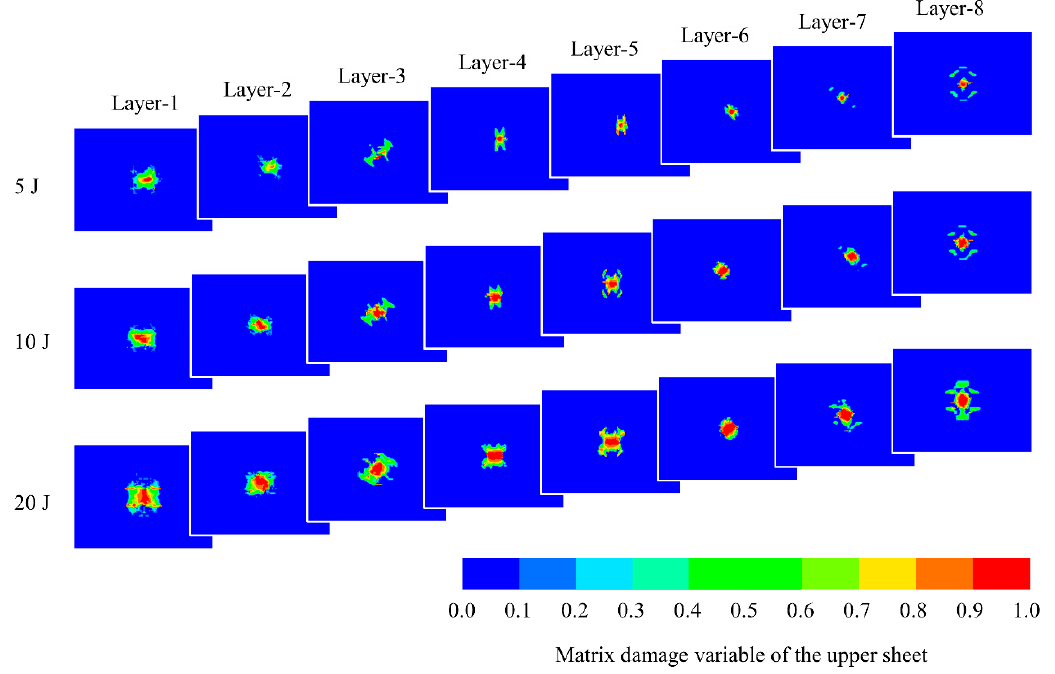
Figure 10. Damage variable of intralaminar matrix in the upper sheet under impact.